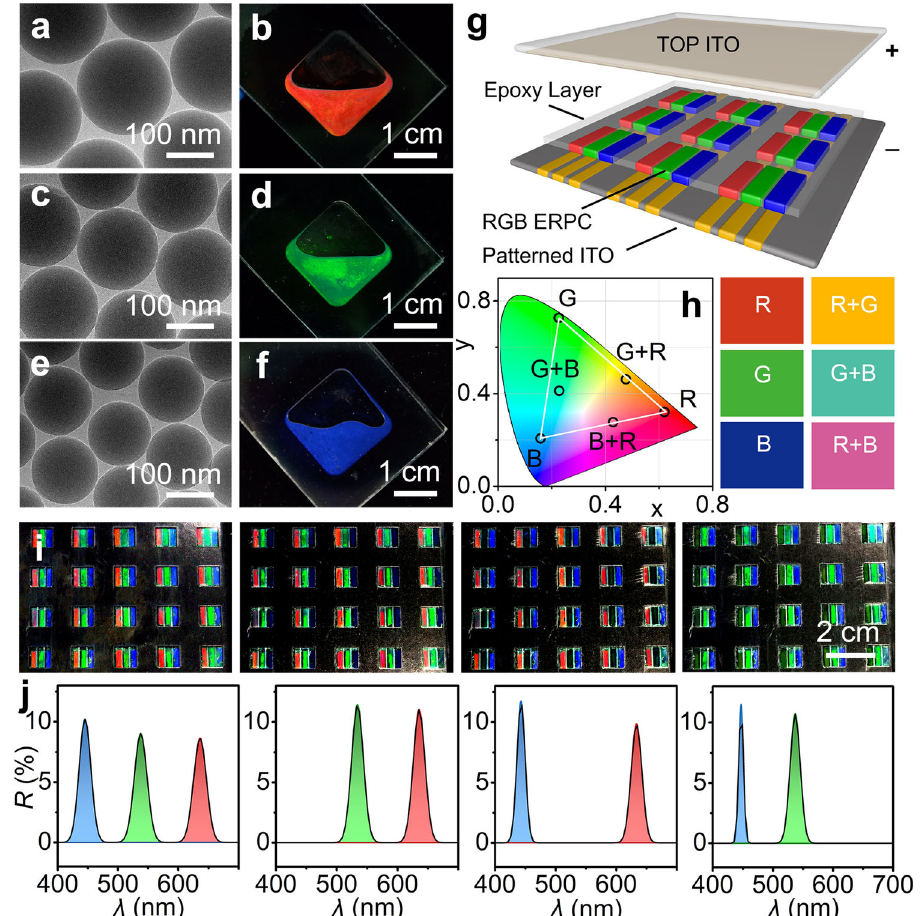
Fig.4 |Multi-colordisplaybasedonbistableERPCs.a – f TEMimagesandphotos of red, green, and blue SiO 2 /PCb-PEG-EG ERPCs (30/60/5/5vol%) prepared by SiO 2 particles with diameters of 199nm, 169nm, and 138nm; g schematic diagram of a prototype display panel composed of RGB pixel arrays; h the chromaticity